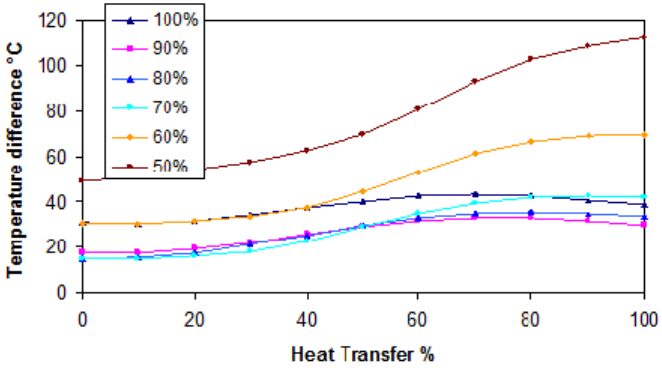
Figure 14. Temperature difference in the exhaust gas boiler with the organic working fluid R123 at full electrical power and the main engine loads from 50% to 100% SMCR.